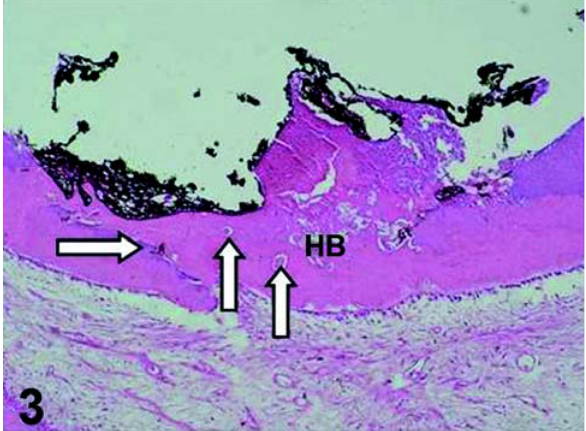
FIGURE 3- Sixty days after applying calcium hydroxide on the pulp tissue, a complete hard tissue barrier (HB) is formed. Note the tunnel defect (horizontal arrow) and cellular inclusions (vertical arrows) within the hard tissue barrier, which is underlined by a new layer of odontoblast-like cells. HE, ×125